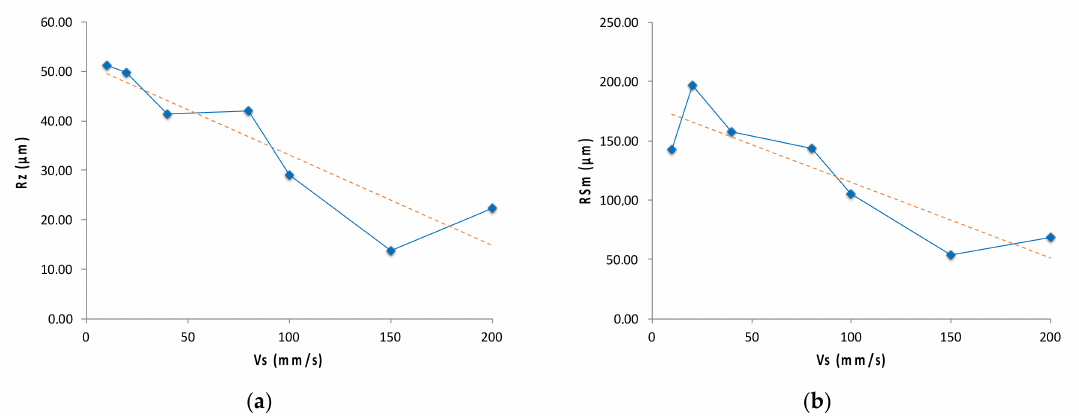
Figure 3. Surface finish behavior as a function of the scanning speed of the beam; ( a ) Rz and ( b ) RSm